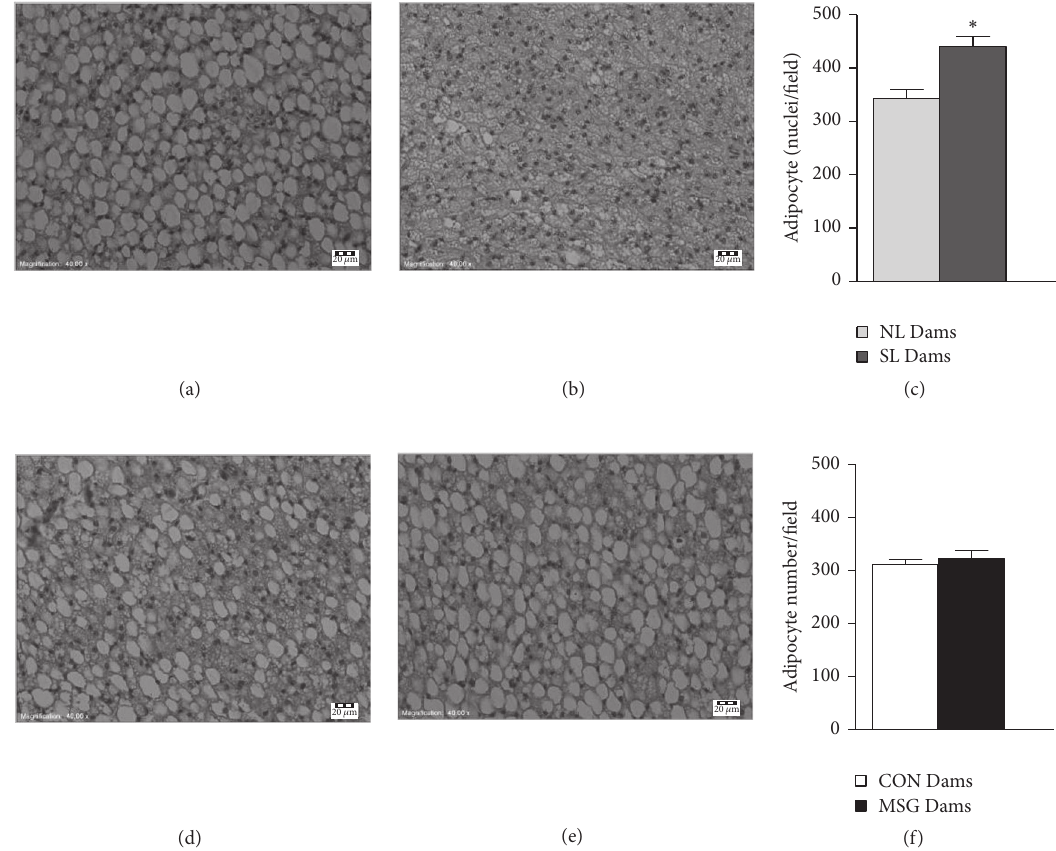
Figure 4: Impact of offspring manipulations on BAT morphology in lactating dams at 21 days of lactation. Representative photomicrographs (magnification 400x; scale bar, 20 𝜇 m) of H&E-stained sections of interscapular BAT from lactating dams (a, b, d, and e). Quantification of adipocyte proliferation evaluated by nuclei counts (c and f). Data are median ± SEM; sections were evaluated from 𝑛 = 3 dams/group and three image fields per section. Symbols above the bars represent statistical differences according to Student’s t -test ( 𝑝 < 0.05 ). ∗ NL Dams versus SL